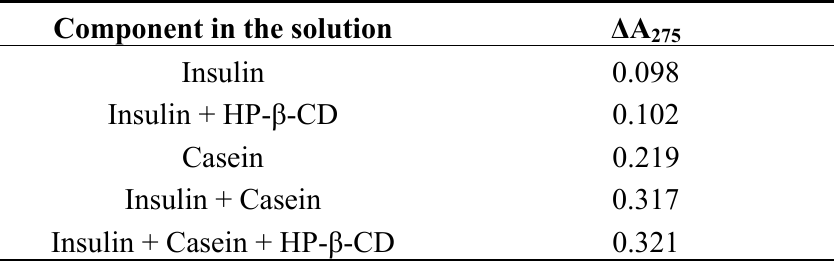
Table 1. The absorption of insulin and casein.